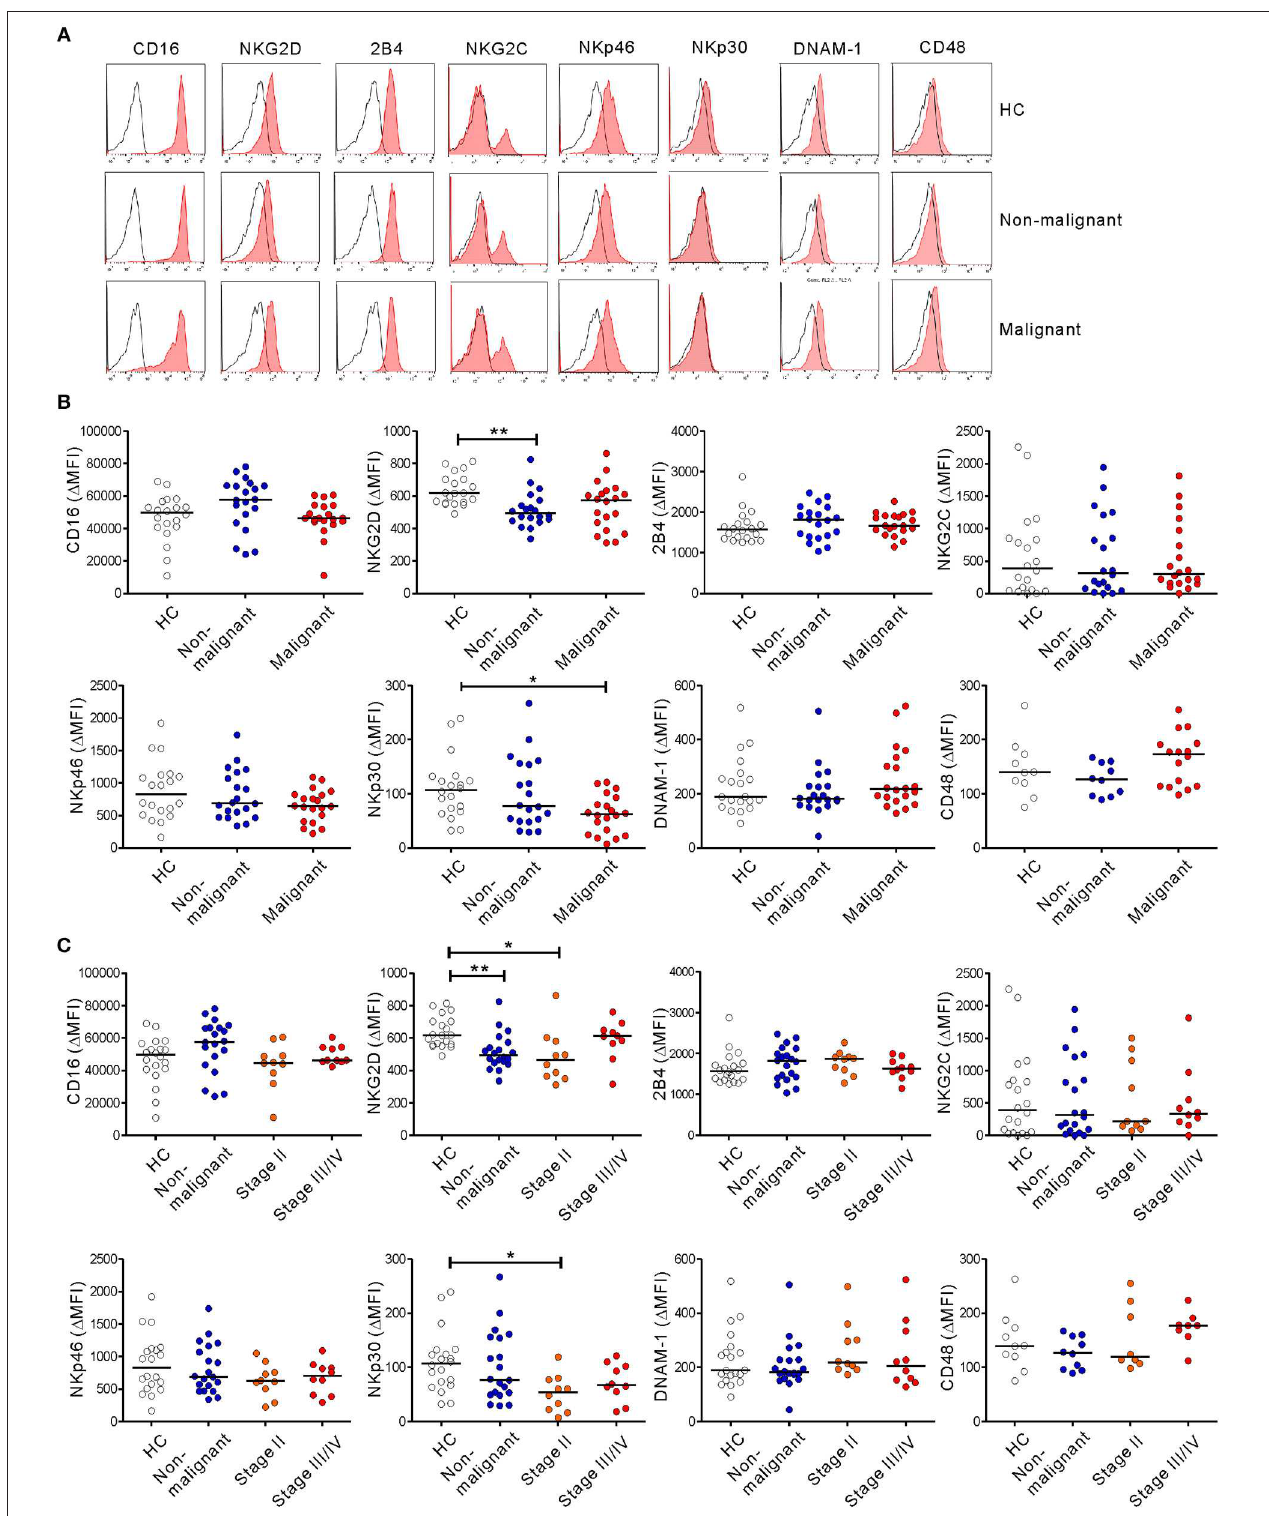
FIGURE 4 | PC patients have altered expression of NK cell-activating receptors. (A) Representative FACS profiles showing the expression of CD16, NKG2D, 2B4, NKG2C, NKp46, NKp30, DNAM-1, and CD48 (red shaded histograms) on gated NK cells in the healthy control (HC) group, the non-malignant group, and